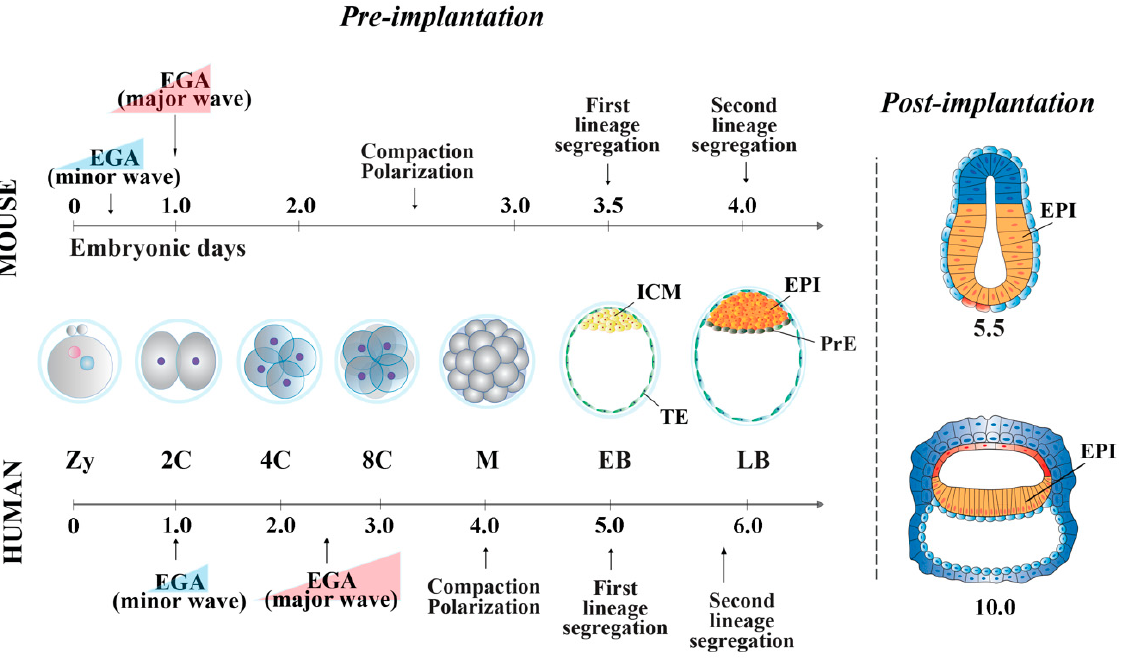
Figure 1. Mouse and human embryonic development from the zygote to early post-implantation stages. Zy, zygote. C, cell. M, morula, EB, early blastocyst. LB, late blastocyst. ICM, inner cell mass. TE, trophectoderm. EPI, epiblast. PrE, primitive endoderm (5.5 dpc and 10 dpf embryos images were redrawn and modified from [24]).